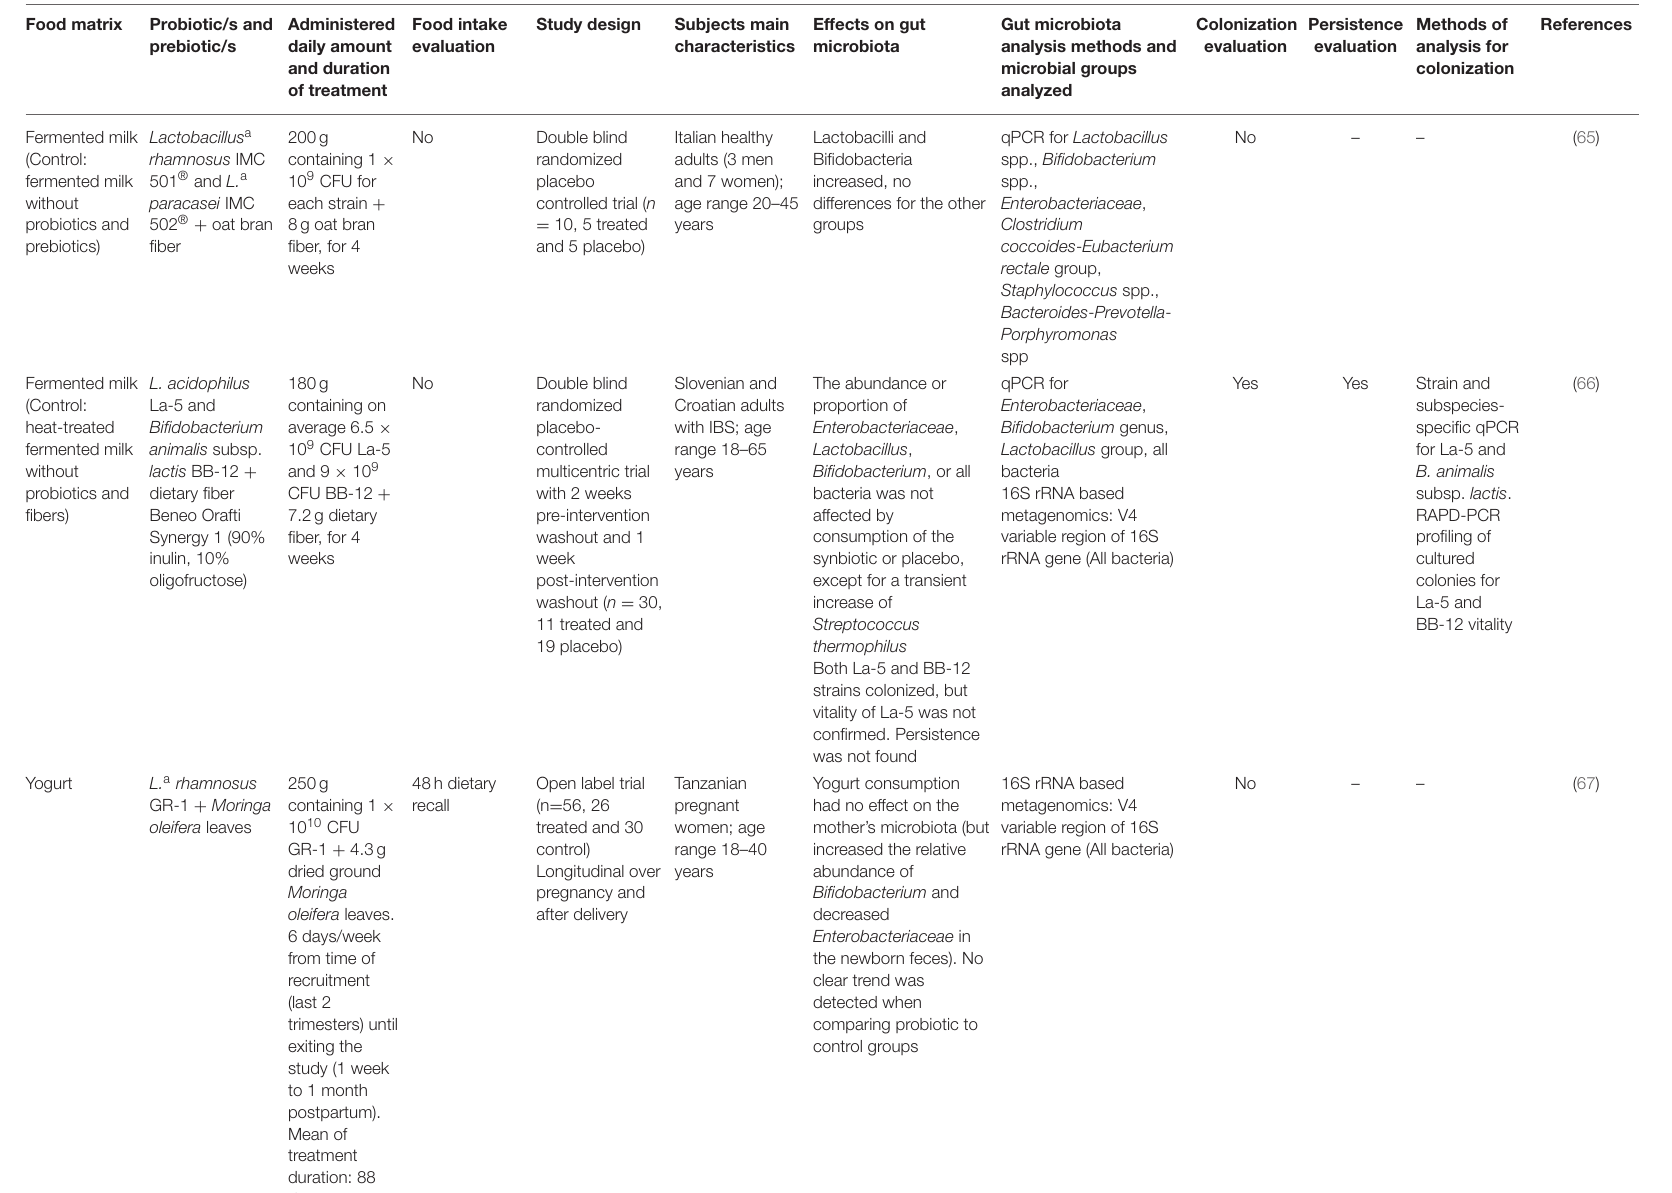
TABLE 6 | Human intervention studies using fermented foods containing